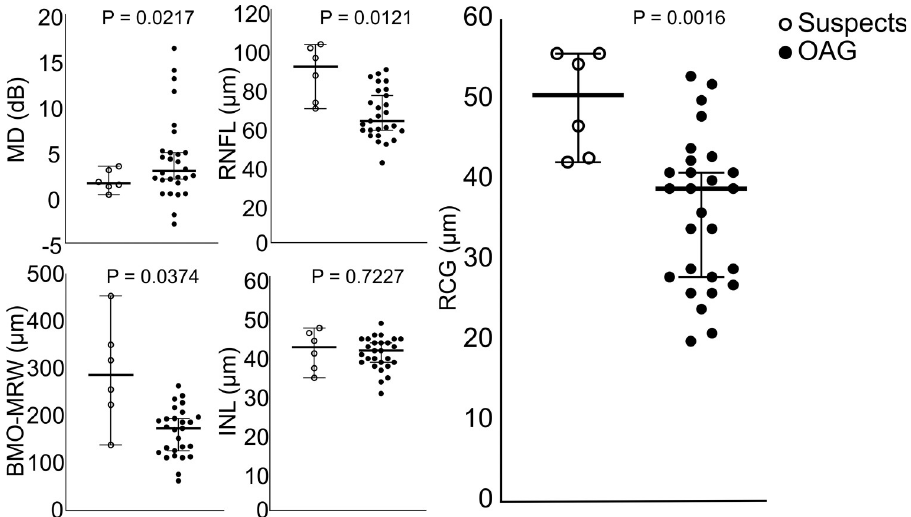
Fig 2. Perimetric and morphometric data of total, glaucoma suspects and patients with open-angle glaucoma (OAG): Mean defect (MD), retinal nerve fiber (RNF), Bruchs’ membrane opening—minimum rim width (BMO-MRW), retinal ganglion cell (RGC), inner nuclear layer (INL).